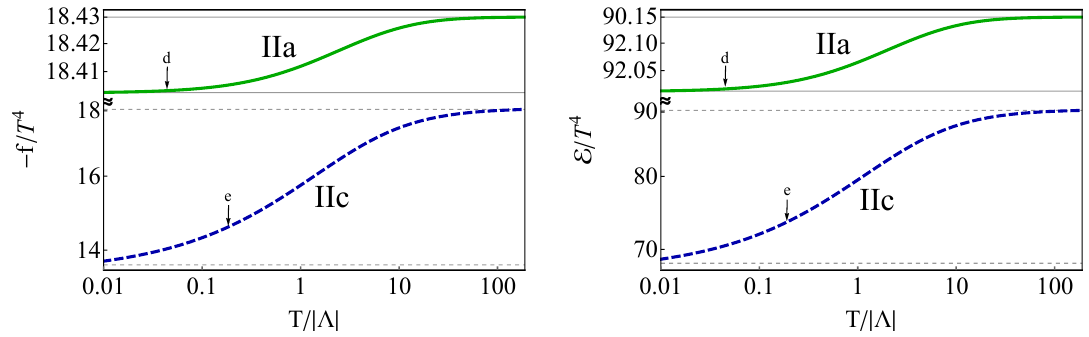
Figure 10 . Free energy density (left) and energy density (right) versus temperature of the CFT 3 with negative source (cid:3). The two continuous horizontal lines correspond to the thermodynamic quantities of Schwarzschild-AdS solutions with (from top to bottom) (cid:30) = (cid:30) 3 and (cid:30) = (cid:30) 2 . The dashed horizontal lines correspond to the thermal branches (from top to bottom) of the CFT 3 and of the CFT 2 with non-vanishing VEV. The locally stable but globally unstable branch is shown in dashed blue, whereas the thermodynamically preferred branch is shown in solid